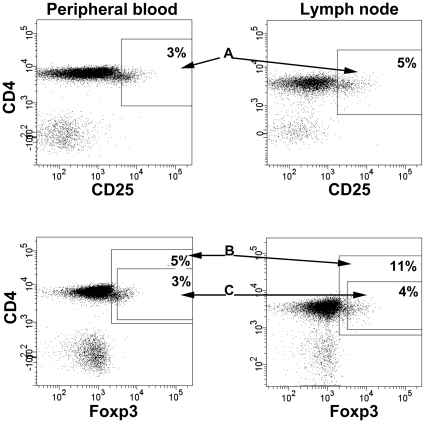
Gating strategies for regulatory T cells.Different strategies for gating regulatory T cells in peripheral blood and lymph node respectively. Panel A; Regulatory T cells is based on CD3 expression (not shown) ,slightly lower (dim) CD4 expression and high (bright) expression of CD25, termed CD4dim/CD25bright
[18] Panel B; Regulatory T cells based on CD3 expression (not shown), Foxp3 expression on CD4 population and with limit of the CD8 population ( = old gating strategy). Panel C; Regulatory T cells is based on CD3 expression (not shown), high (bright) expression of CD25 (not shown), slightly lower (dim) CD4 expression and high Foxp3 expression. Values are given as percent CD3+4+. Examples from one ACS (acute coronary syndrome) patient shows dot plots representative for both SA (stable angina) and ACS patients.